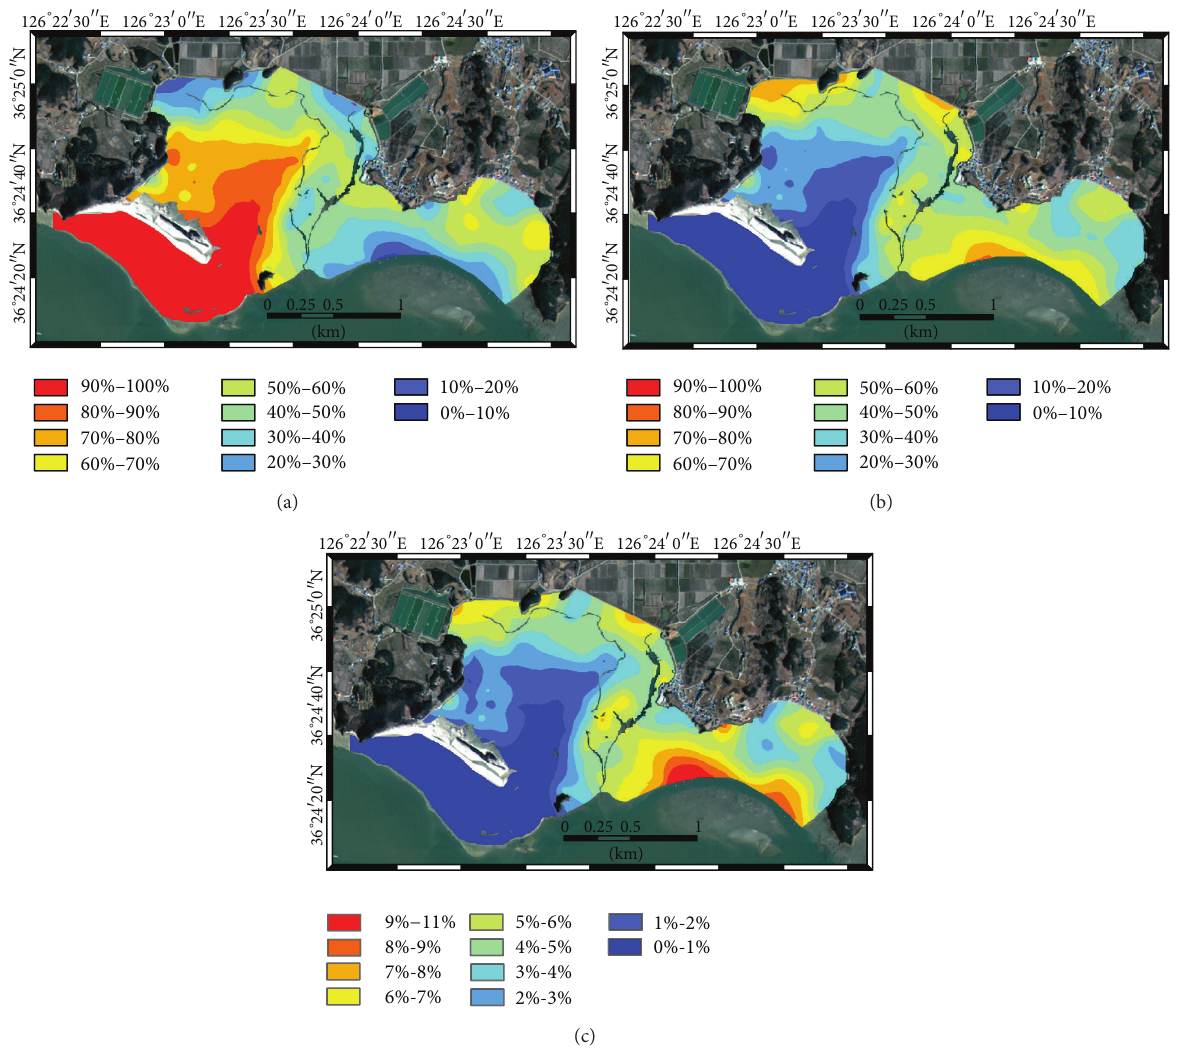
Figure 6: Spatial distributions of fractions generated by cokriging of original fractions: (a) sand, (b) silt, and (c)